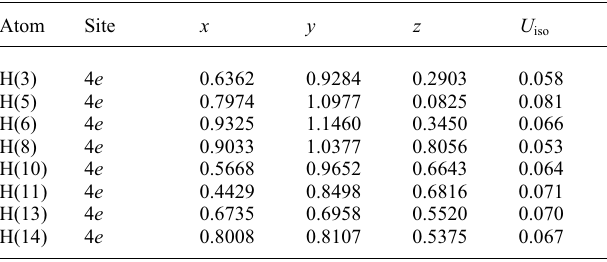
Table 2. Atomic coordinates and displacement parameters (in Å 2 )